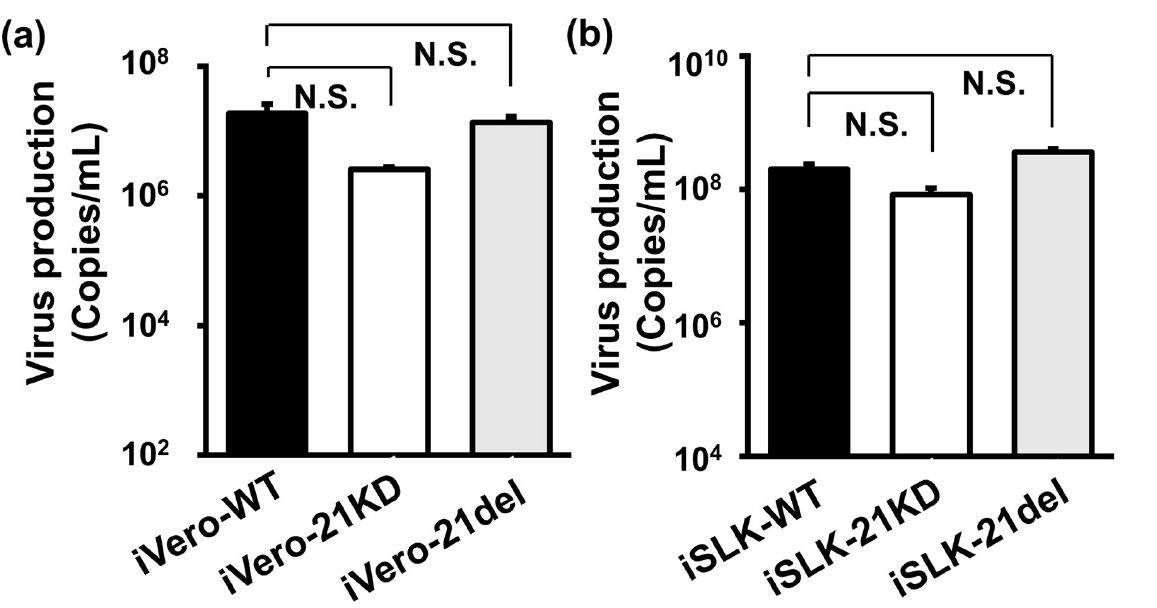
Figure 4. The effects of ORF21 on the production of cell-free genome-encapsidated particles. ( a ) Re- combinant BAC16-harboring iVero cells (iVero-WT, iVero-21KD, and iVero-21del) or ( b ) iSLK cells (iSLK-WT, iSLK-21KD, and iSLK-21del) were cultured for 48 h in a medium with Dox and NaB, and the culture supernatants were harvested. KSHV genomes were purified from the cell-free genome- encapsidated particles in culture supernatants, and viral DNA copies were determined by real-time PCR. N.S., not significant.